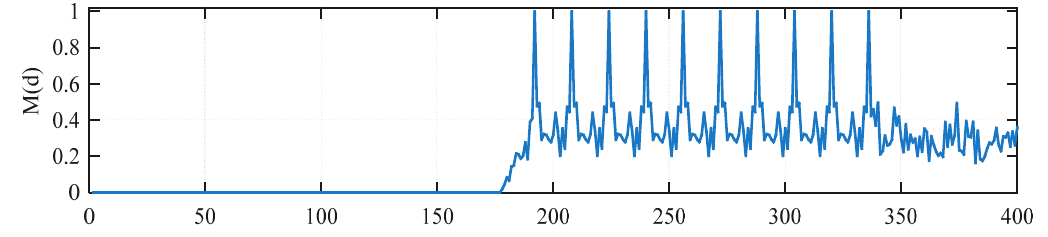
Figure 5. M ( d ) of Liu method in ideal